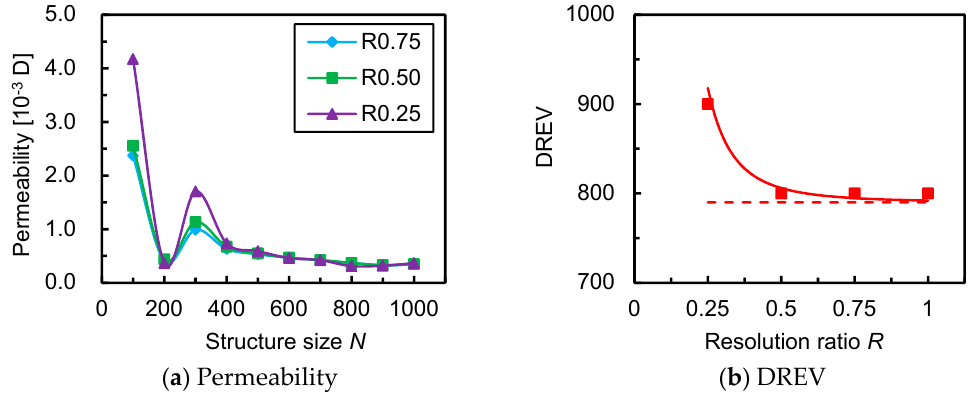
Figure 11. Influence of resolution on sample size effect. ( a ) Sample size effect on calculated permeability at varying resolutions; ( b ) Influence of resolution on DREV. Solid line is schematic plot and dashed line is asymptotic line of solid line.